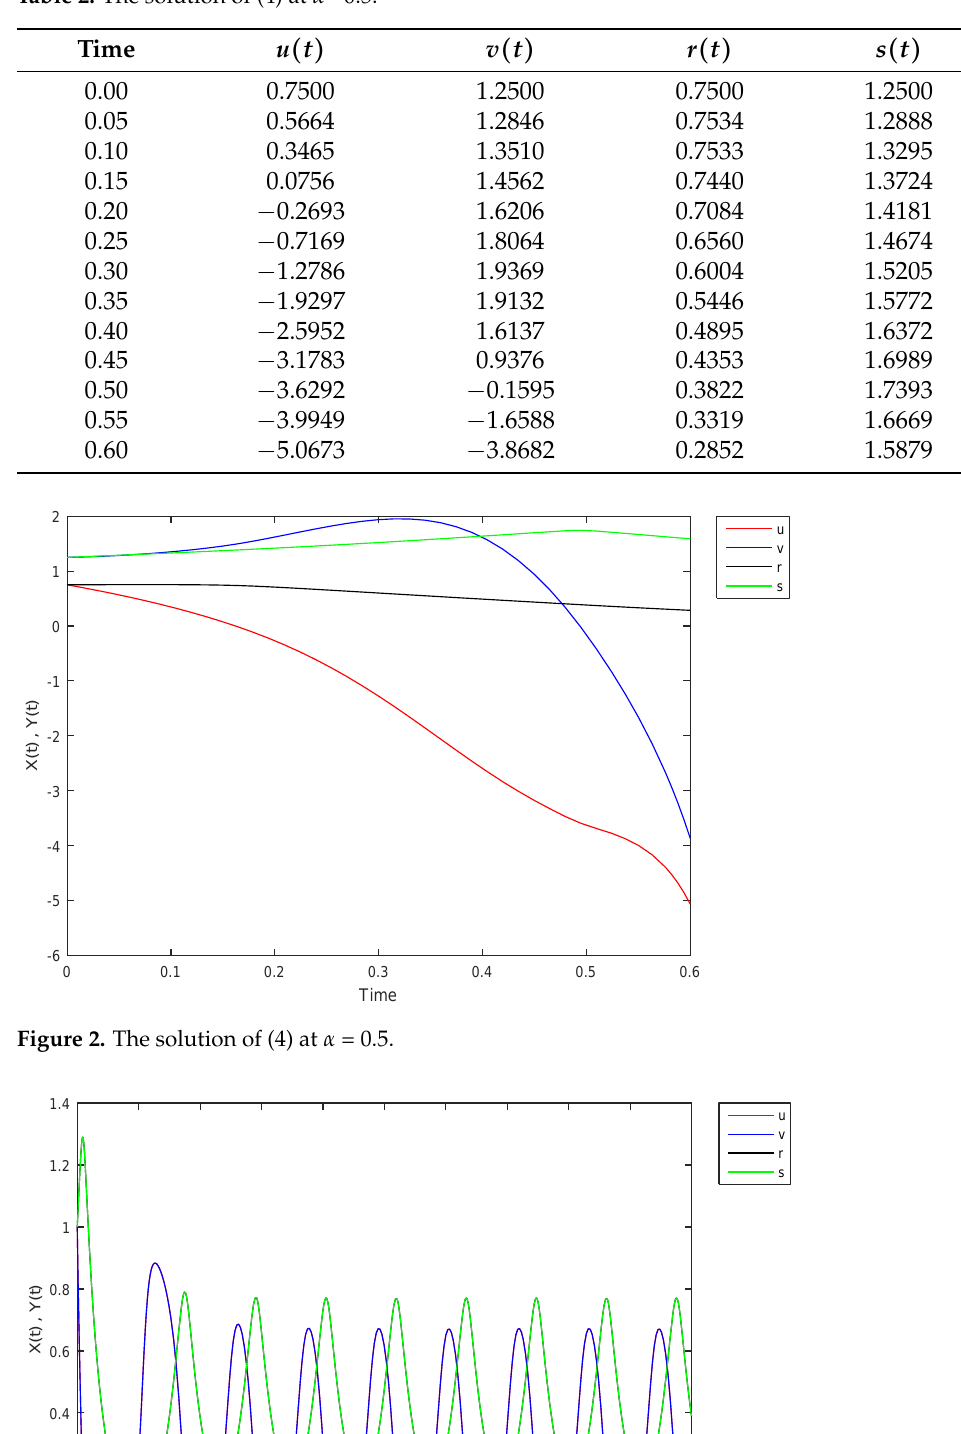
Table 2. The solution of (4) at α = 0.5.